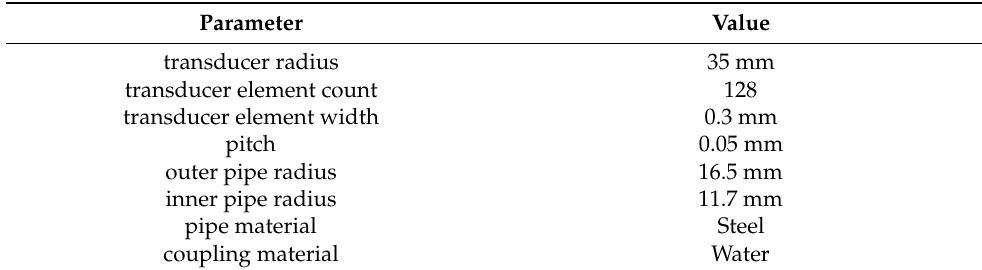
Figure 3. Simulation scenario as configured in CIVA. Table 1. Simulation scenario parameters.